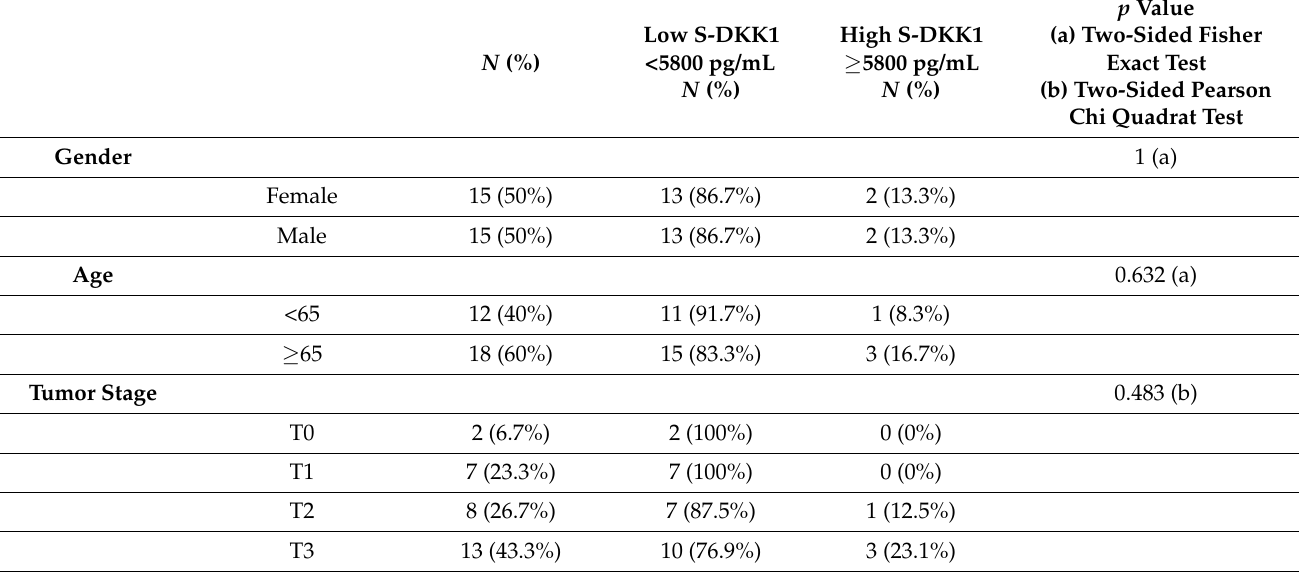
Table 2. Subgroup analysis of esophageal squamous cell cancer patients with respect to DKK1 serum